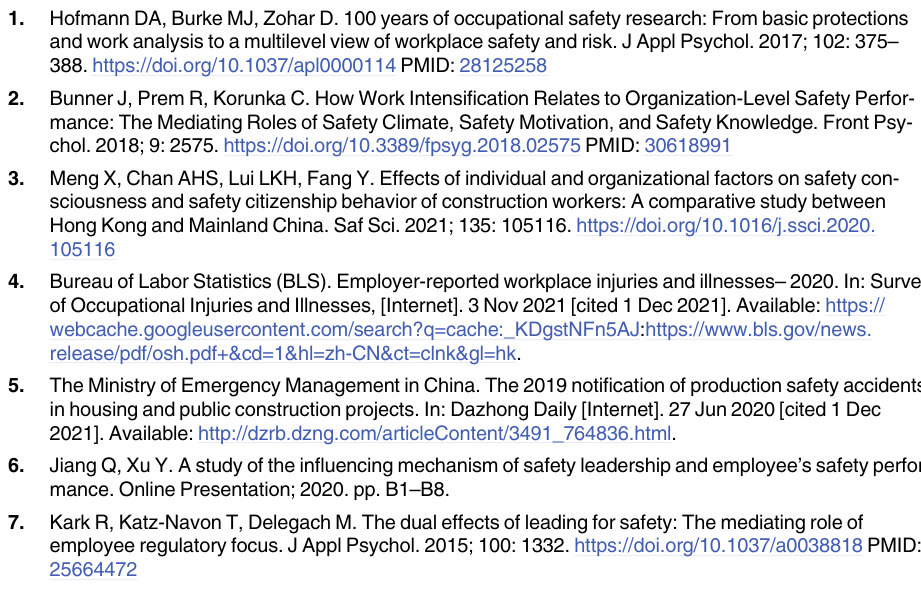
S6 Table. Conditional indirect effects of transformational leadership on safety compliance at values of perceived safety